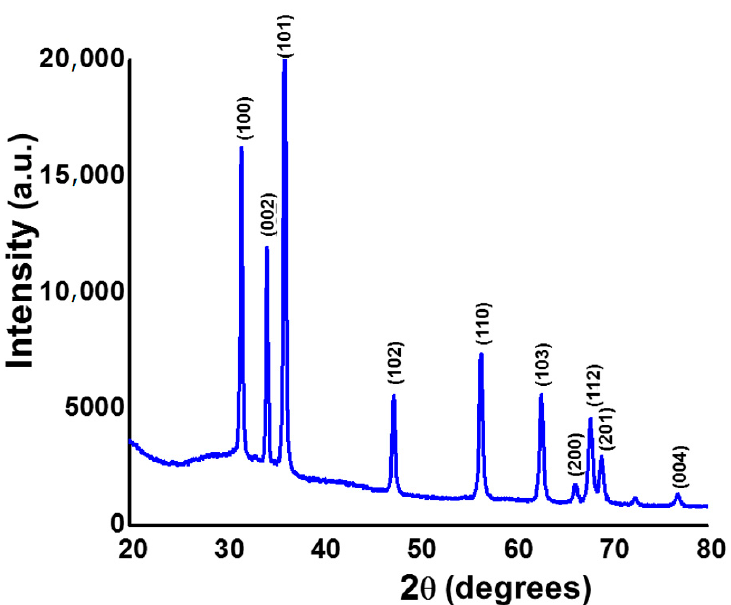
Figure 1. The intensity vs. 2 θ profile obtained for the ZnONPs prepared using aqueous root extract of Withania somnifera, suggesting that this pattern clearly belongs to the hexagonal crystal structure (JCPDS data of 36-1451).